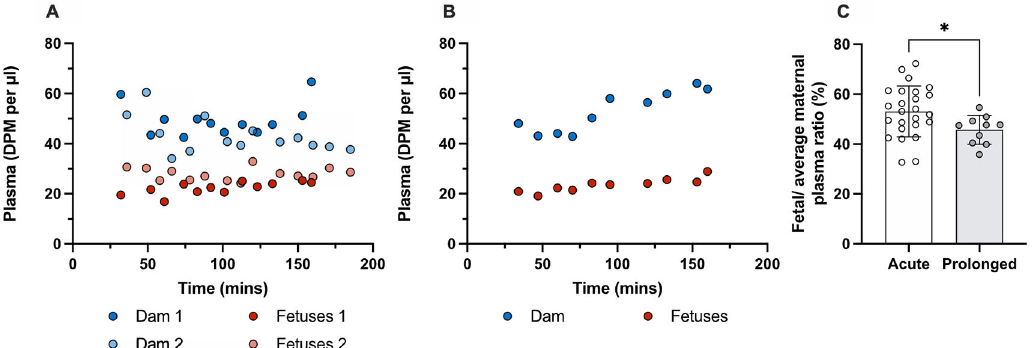
Figure5.Counts(DPM/ μ l)inplasmaofdamsandtheirfetusesatE19. (A)Asingleintravenous( i.v. )injectionof0.15 mg/kg olanzapine with a radioactive tracer ([ 3 H]olanzapine) to each dam and (B) counts (DPM/ μ l) in plasma after 4 daily intraperitoneal ( i.p. ) injections of 0.15mg/kg olanzapine followed by olanzapine with a radioactive tracer ([ 3 H] olanzapine) i.v. on the 5 th day. (C) Placental transfer as calculated by fetal/average maternal plasma ratio (%) using results from A and B. Bars are means (cid:3) SD. Note dam values are serial plasma samples taken between 30 – 160 min post maternal injection from one or two individual dams, fetal values and ratios are from individual animals (n=10 – 25). *p<0.05.